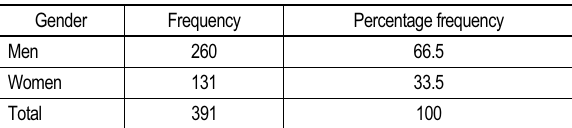
Table 1. Distribution of the percentage frequency of